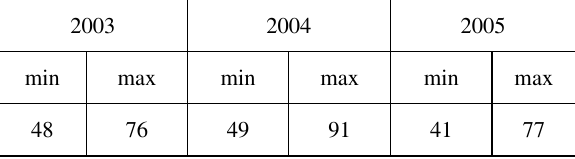
Fig 1. Lithuanian marine area of the Baltic Sea